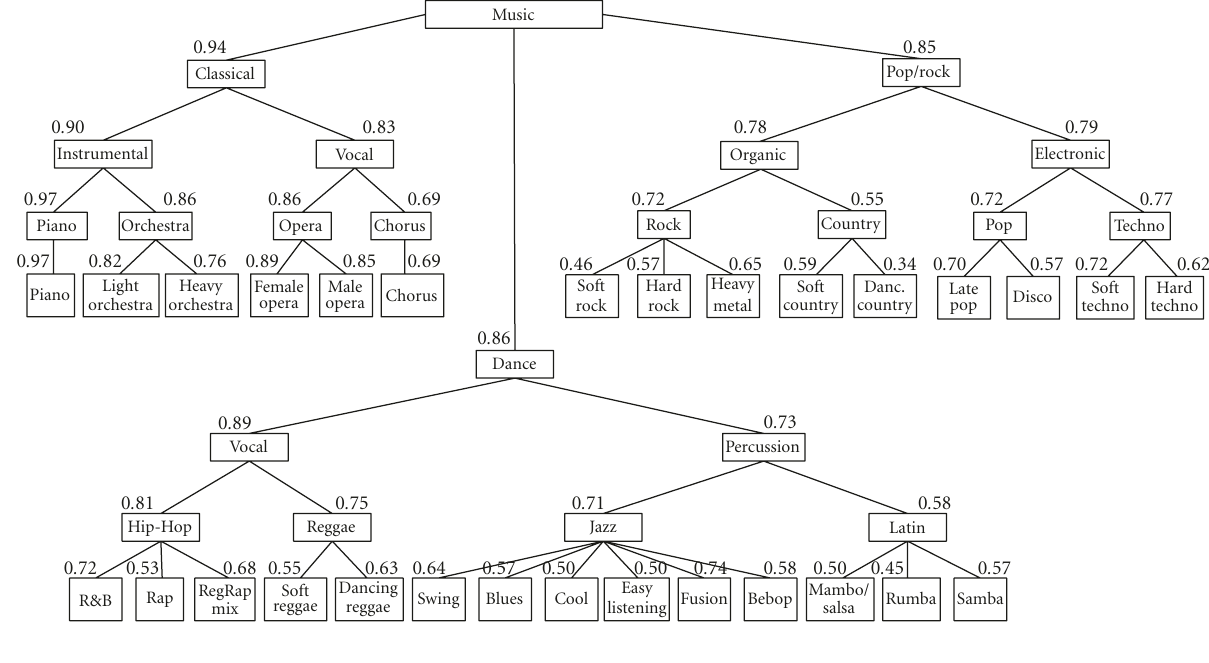
Figure 4: Accuracy for each genre and class in all layers.